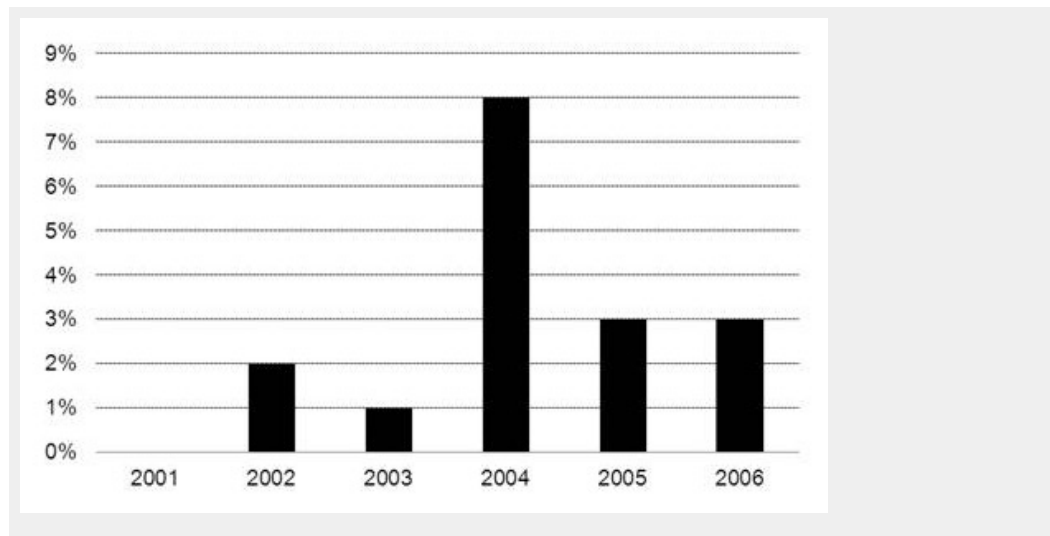
Figure 4 Percentage of negative appendectomies by the surgeon during the